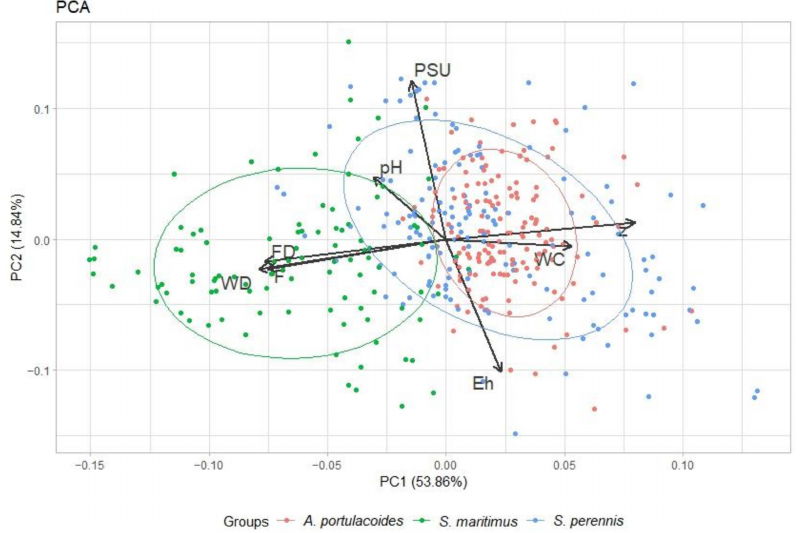
Figure 7. Principal component analysis (PCA) grouped by species for physicochemical and hy- drodynamic variables. Mean flood duration ( FD ); frequency of flooding ( F ); water depth ( WD ); water content ( WC ); soil elevation ( z ); pH ; salinity (PSU); and redox potential ( Eh ). The data are representative of a period of 10 months, from December 2021 to September